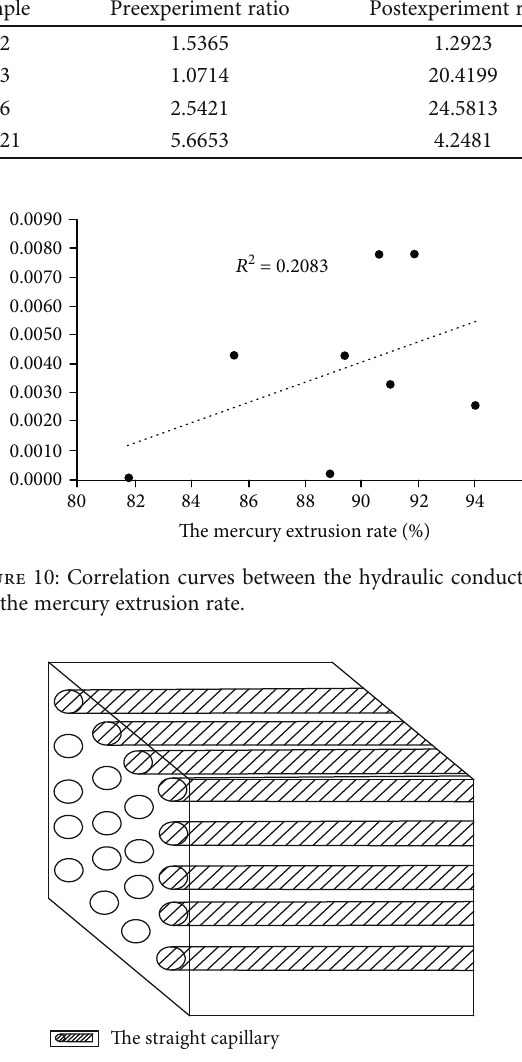
Figure 11: Schematic image of the straight capillary